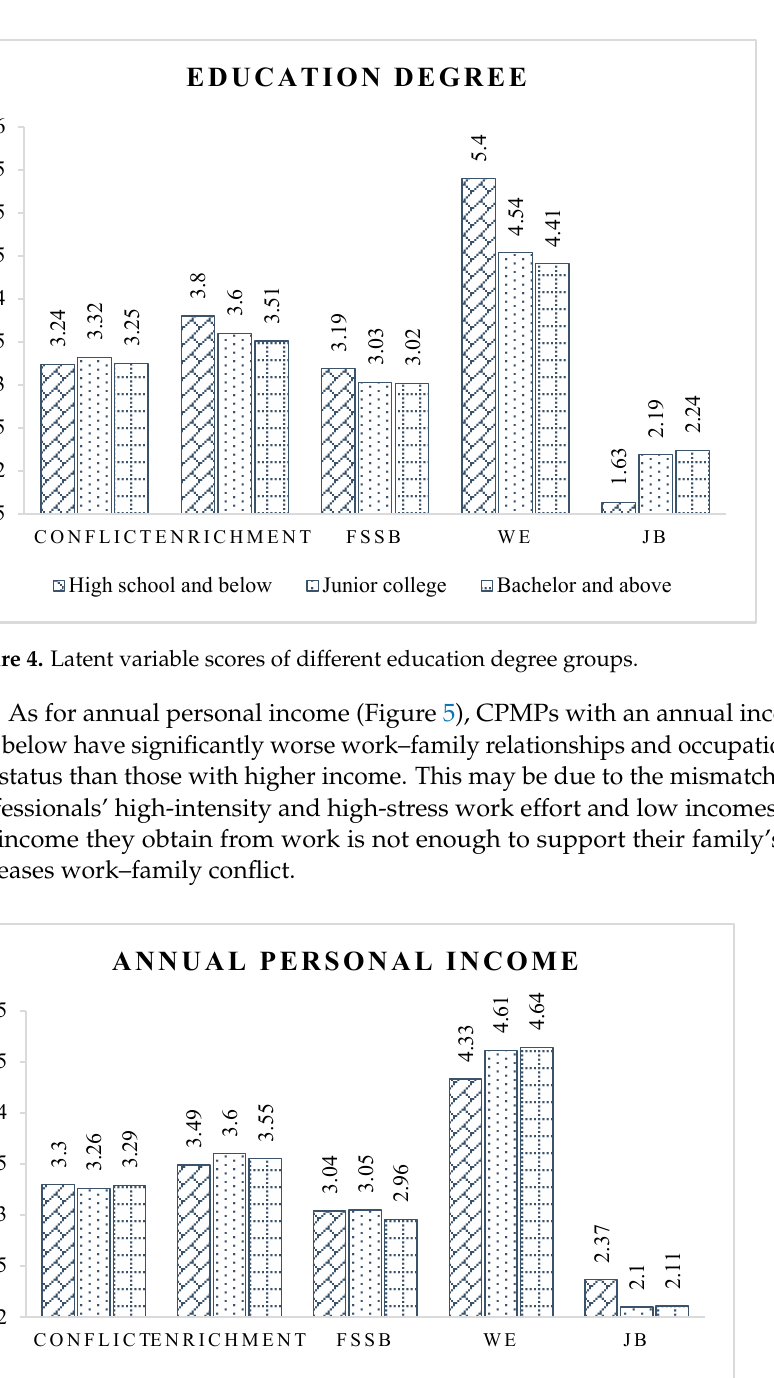
Figure 3. Latent variable scores of different gender groups.